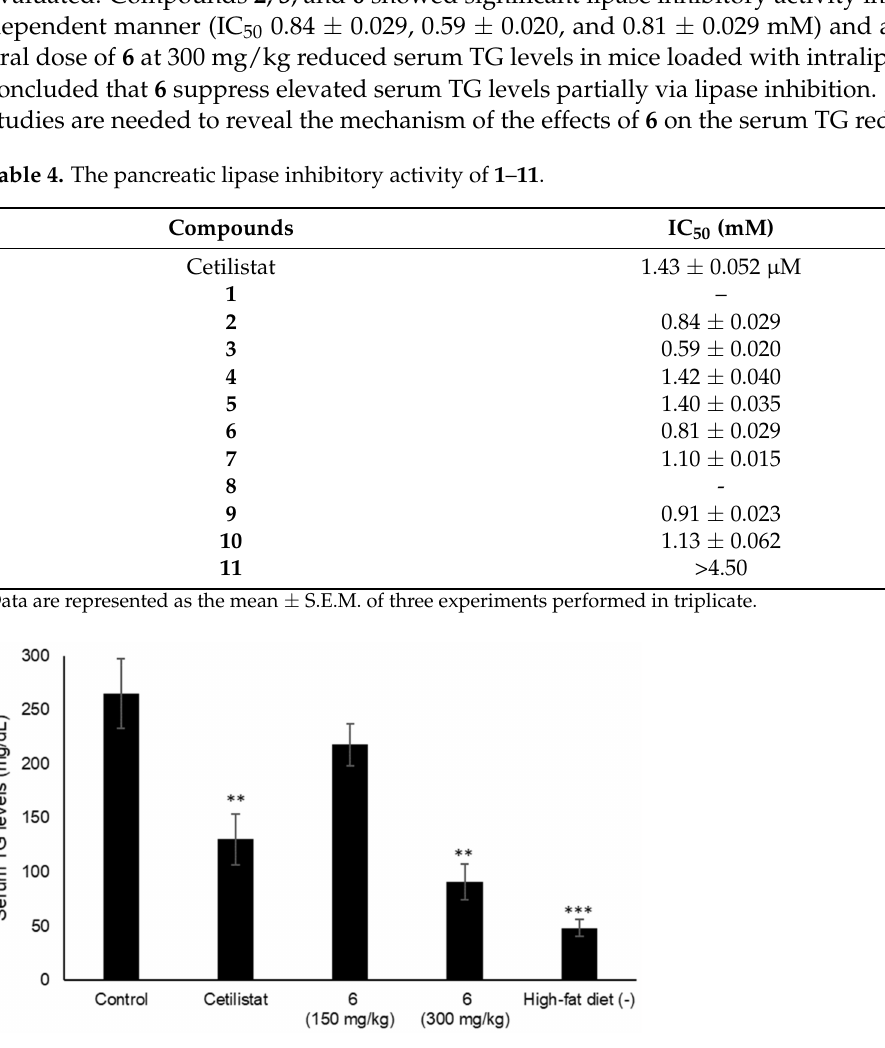
Figure 4. Effects of 6 on the serum TG levels in mice fed a single-dose administration of a high-fat diet. Compound 6 (150 or 300 mg/kg) and cetilistat (180 mg/kg); Data are represented as the mean ± S.E.M. ( n = 5); *** p < 0.0001 vs. control, ** p < 0.001 vs.